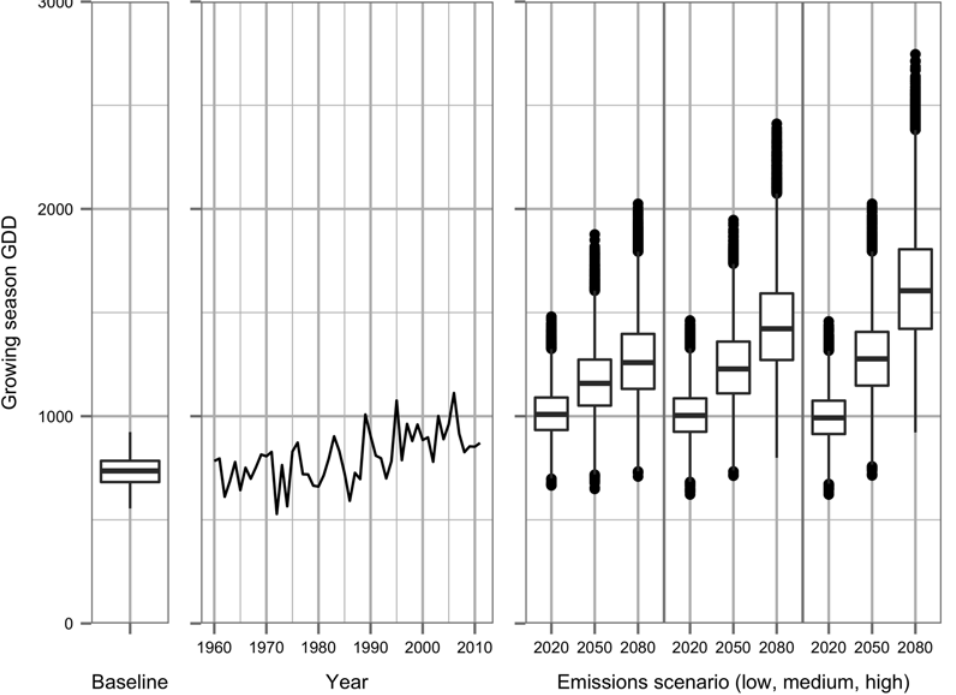
Fig 2. Changes in cumulative growing season GDD (1 st April to 31 st October) calculated from baseline (1960 – 90) weather generator runs, daily historic weather data (1960 – 2011) and future climate weather generator runs using three emissions scenarios (low, middle and high emissions from left to right) and time periods. Baseline quantile box plots calculated from 9,000 30-year time sequences; future box plots from 1,000 30-year time sequences.